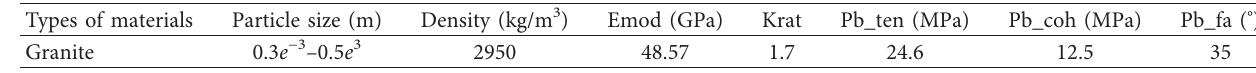
Table 1: Model parameters of rock.